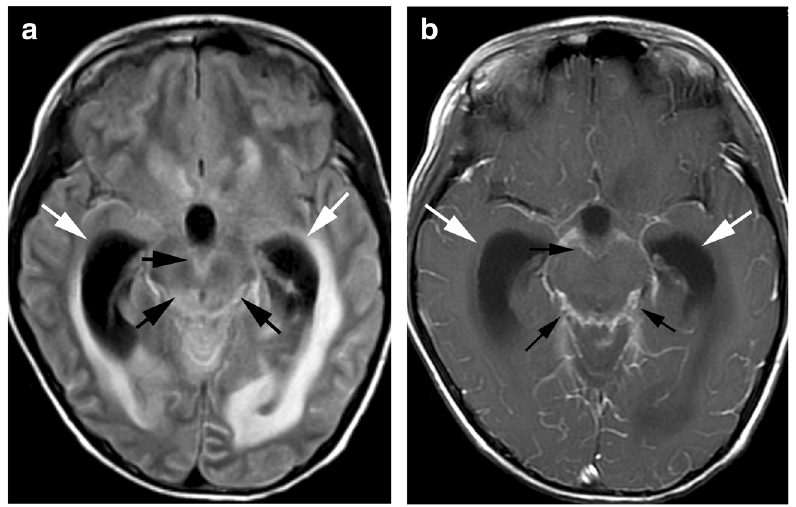
Fig. 4 Pyogenic meningitis. An 8-year-old boy with acute myeloid leukaemia, who had received chemotherapy including intensification treatment, presented with esotropia. a FLAIR image shows hyperintensities along the surface of the brain stem ( arrows ). Communicating hydrocephalus is also seen ( white arrows ). b These lesions show enhancement ( arrows